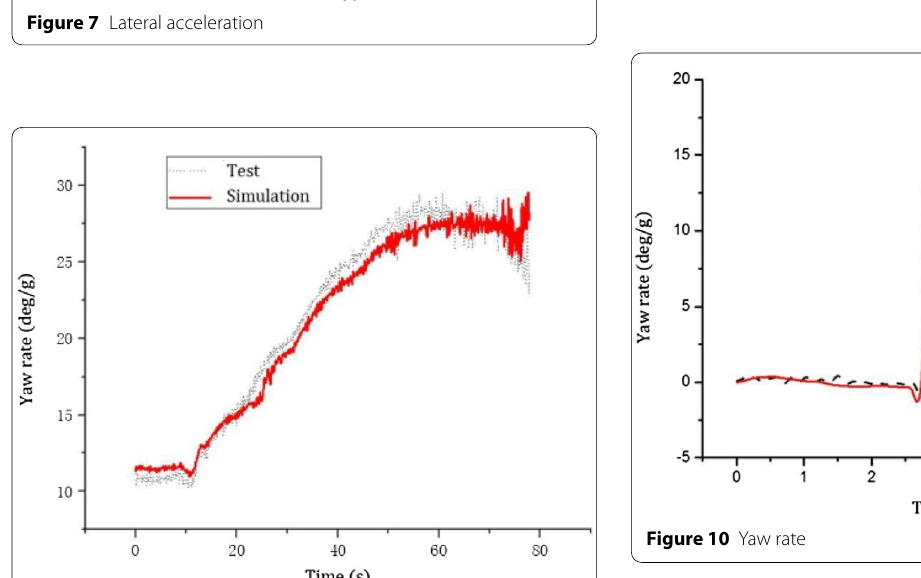
Figure 10 Yaw rate